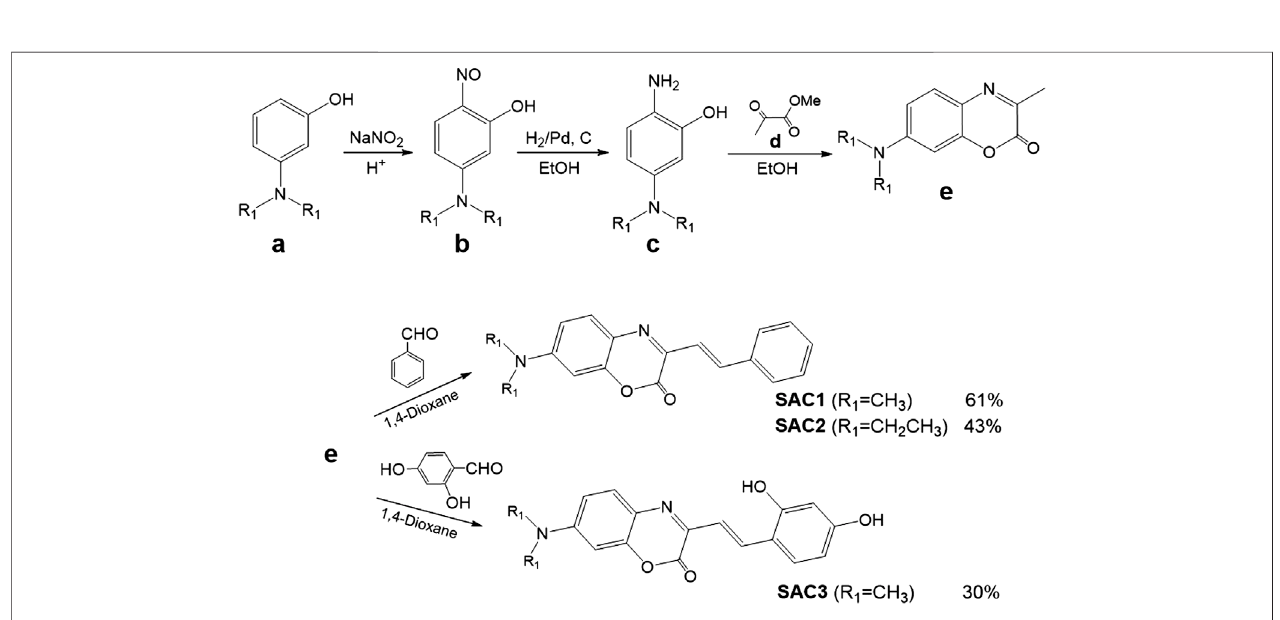
FIGURE 1 | Representation of: (A) Series of 3-styryl derivatives of 7-(dialkylamino)-aza-coumarins ( SAC1-3 ) and (B) cucurbit[7]uril (CB7).